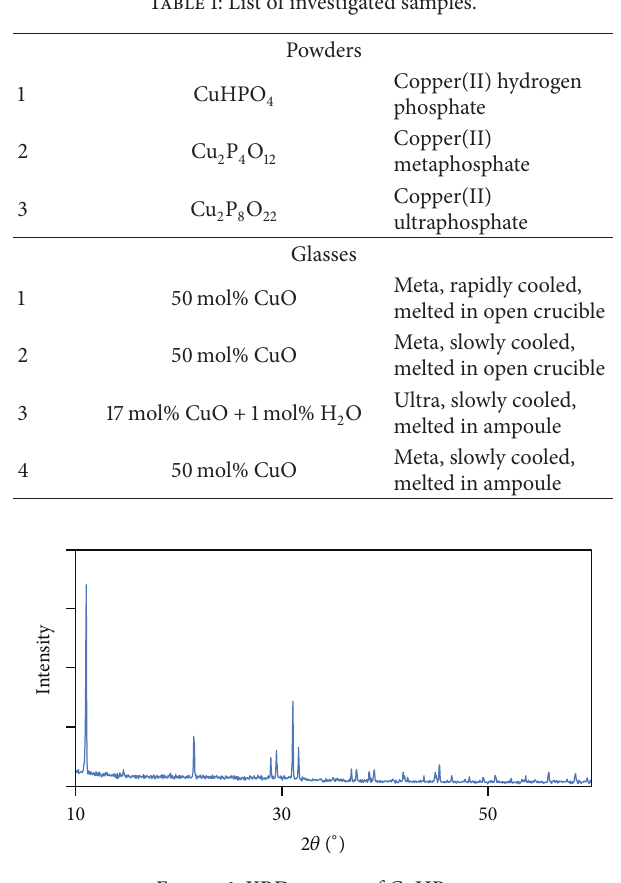
Figure 1: XRD pattern of CuHPo 4